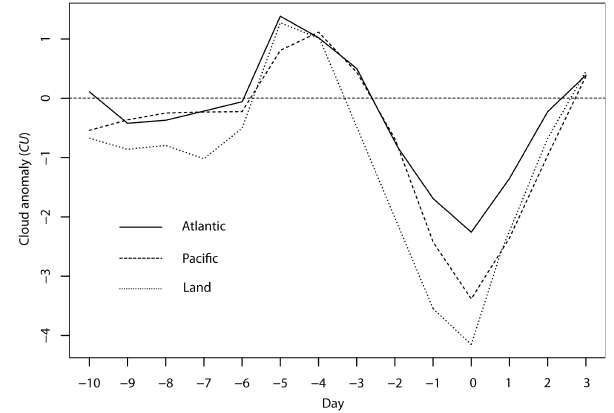
Fig. 6. The mean rate of IR-detected cloud change (30–1000mb) over mid-latitude regions between days − 10 and +3, over land regions (dotted line) and Pacific/Atlantic ocean areas (solid and dashed lines